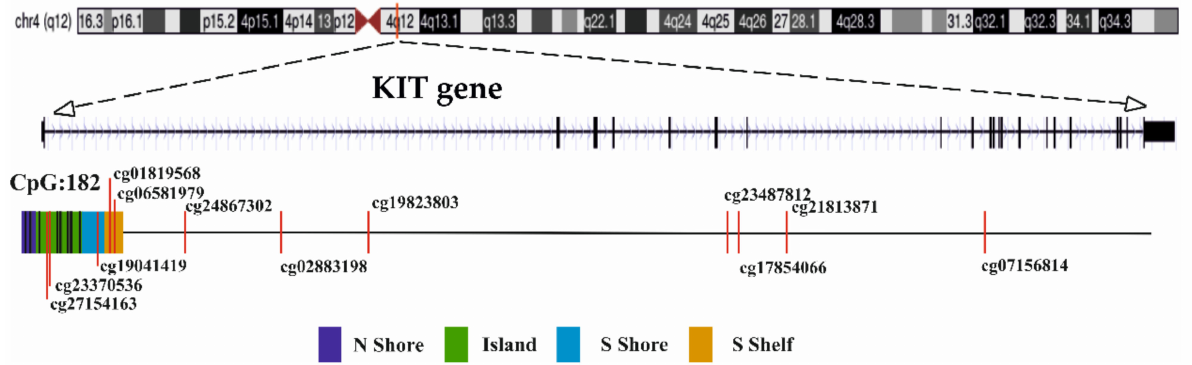
Figure 6. Location of studied CpG sites within KIT gene. Methylation β values in positions highlighted in red differed significantly between D3 and M3 tumors and between those with negative and positive protein expression.